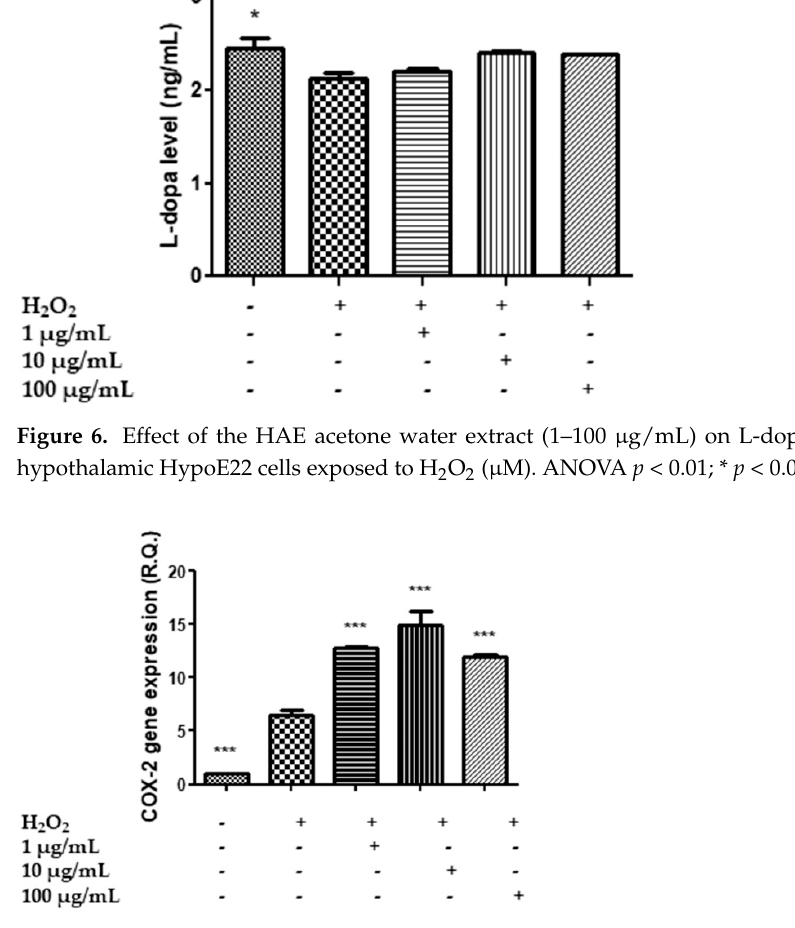
Figure 8. ELISA assay for PGE 2 secretion of cultures at 48 h. The secretion levels are reported as pg/mL. The data shown are the mean (±SD) ( n = 3). * p < 0.5 vs H 2 O 2, • p < 0.05 vs. 1 µg/mL+H 2 O 2 ; ¢ p < 0.05 vs. 10 µg/mL + H 2 O 2. 2.8. In Silico Study Aiming to shed light on the mechanisms underlying the observed effects, an in silico prediction was conducted considering the prominent extract’s phytocompounds charac- terized by a well-defined structure, namely acacetin, hesperidin, eriodictyol, sagerinic acid, naringenin, luteolin, chlorogenic acid, chrysoeriol and apigenin (Figure 9). These compounds were predicted to interact with a wide number of protein families, including oxydoreductases and hydrolases (Figure 10). Additionally, in this context, the putative interactions with MAO-A, MAO-B, COX-2, tyrosinase and cholinesterases are consistent both with our present findings of enzyme inhibition exerted by the extract and literature data demonstrating the enzyme inhibition properties of the aforementioned phytochemi- cals [87–93].